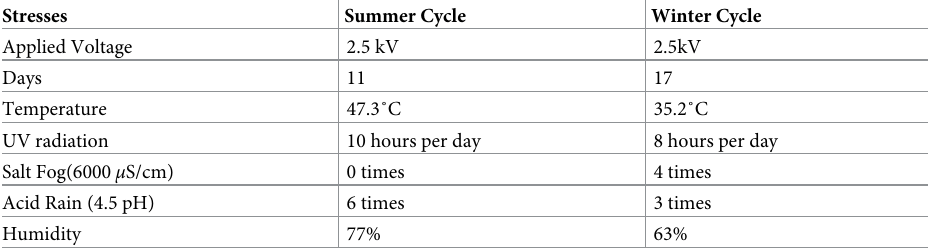
Table 2. Winter and summer cycle